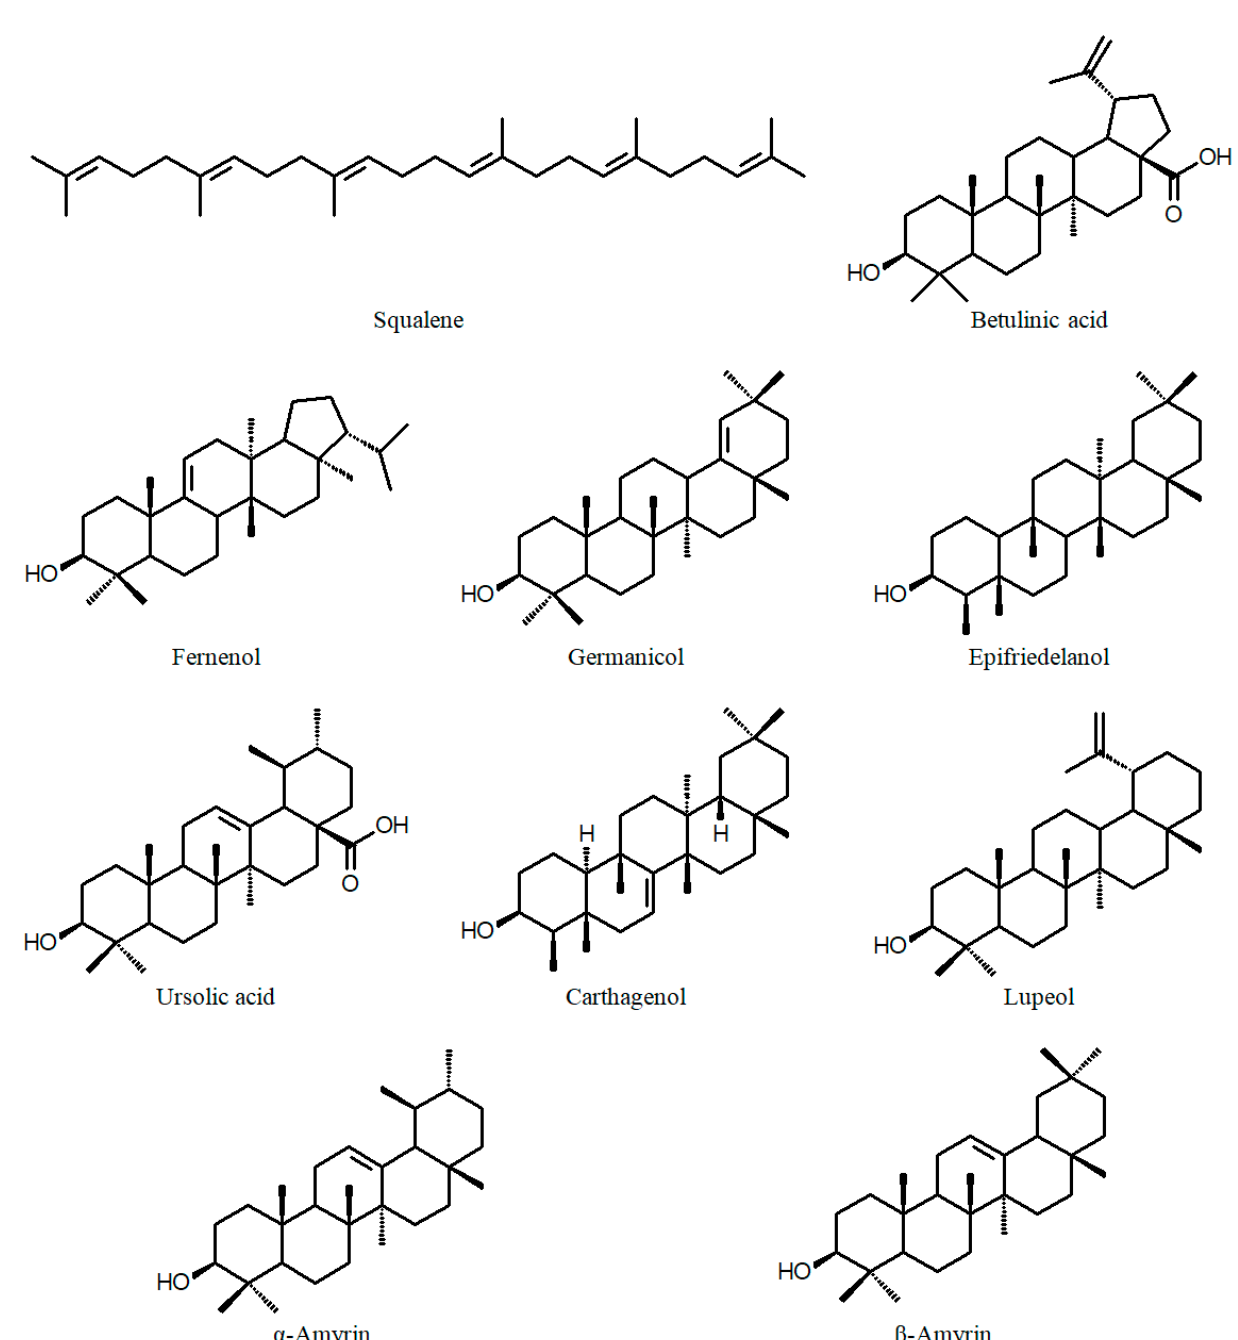
Figure 5. Chemical structures of triterpenes of the genus Cuphea .